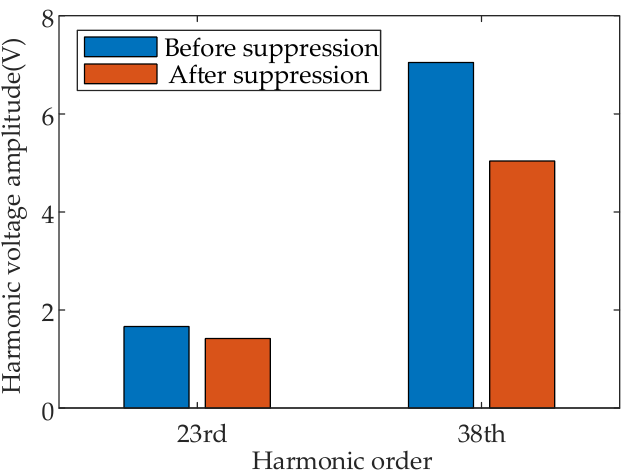
Figure 20. The comparison of the harmonic voltage of Inverter 1 before and after adopting the resonance suppression strategy.